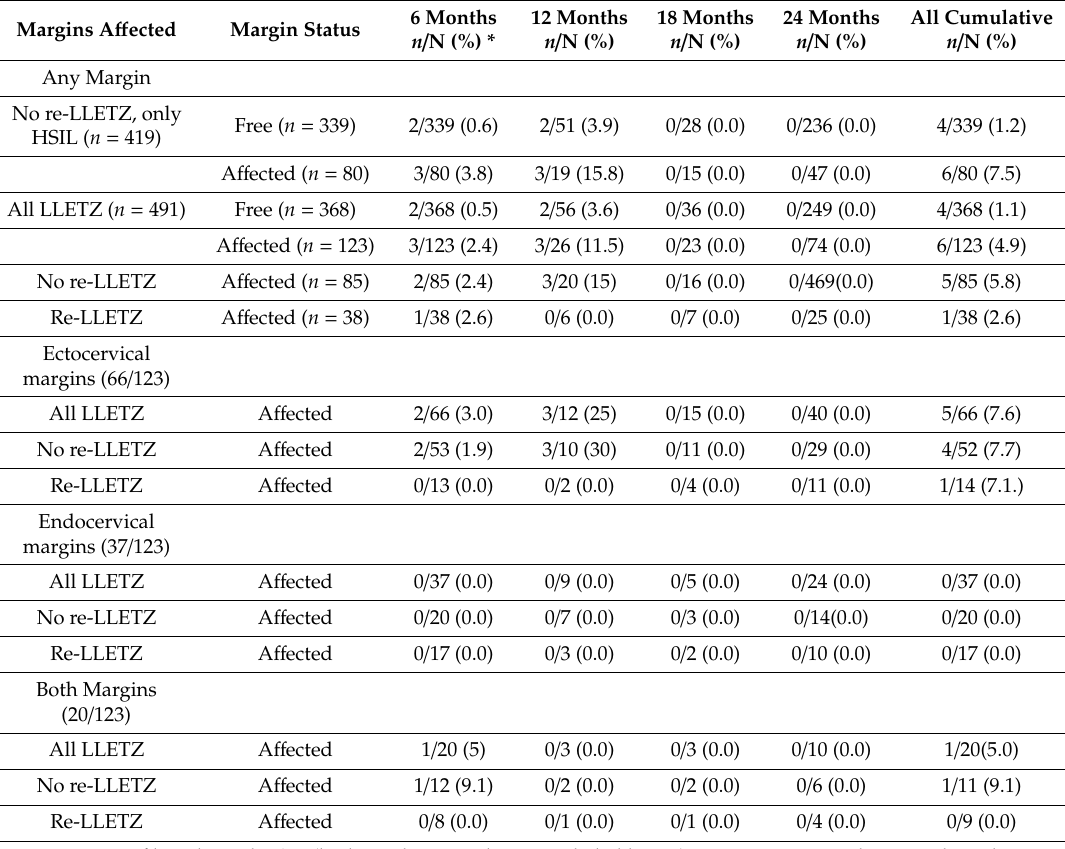
Table 4. Recurrence of HSIL lesions during the 24-month follow-up after LLETZ: according to the resection margin status of the first LLETZ and separately for all women regardless for histopathology and according to whether reoperation for a ff ected margins was